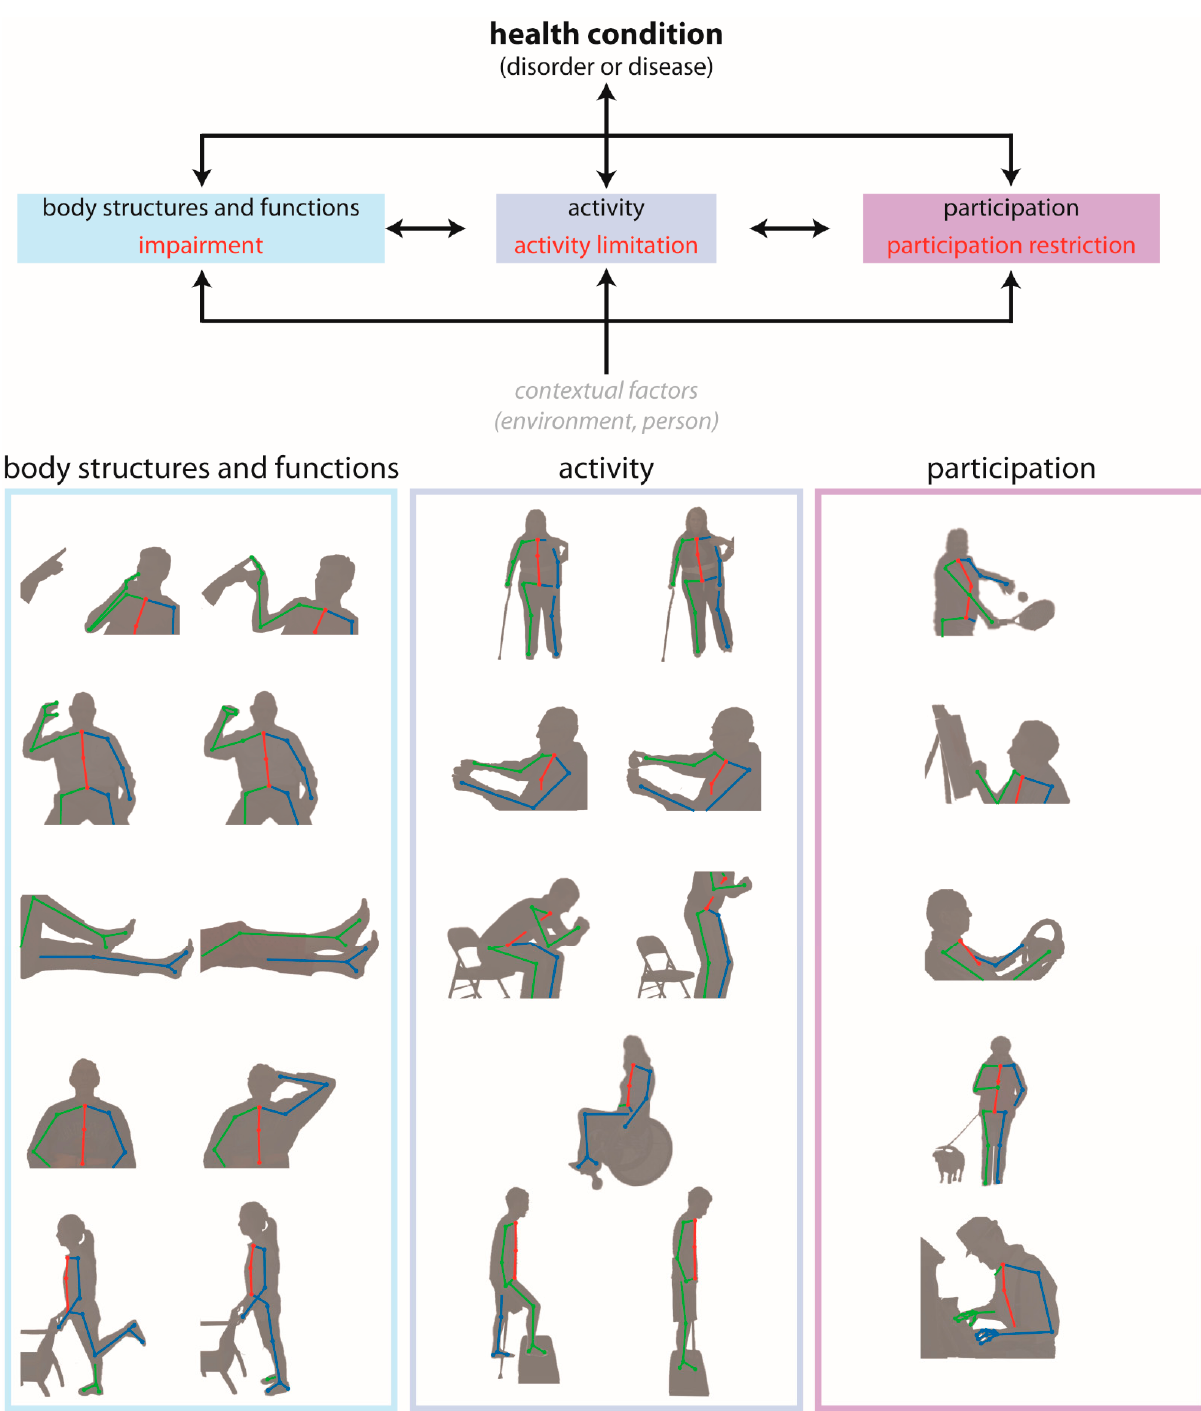
Figure 4. Depiction of potential applications of pose estimation for movement tracking during clinical assessments across the domains of the International Classification of Functioning, Disability and Health (ICF) model. For instance, finger–nose coordination testing the body structures and functions domain ( left ), walking assessment in the activity domain ( middle ), and playing tennis in the participation domain ( right ).